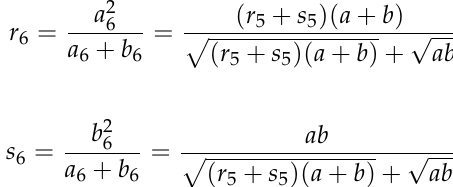
Figure 8: Geometric constructions of r 5 = a 4 s = b 2 . a + b